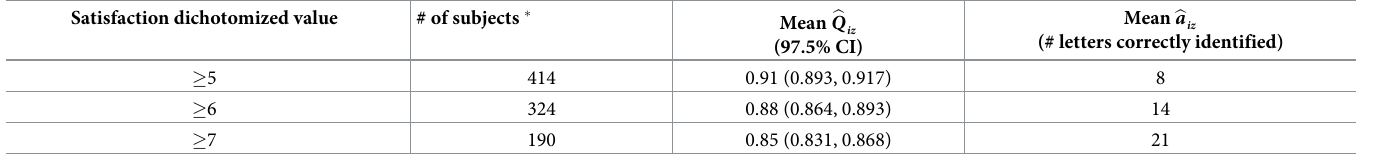
Table 4. Mean b Q and mean b a in the change of UCNVA. iz iz Satisfaction dichotomized value